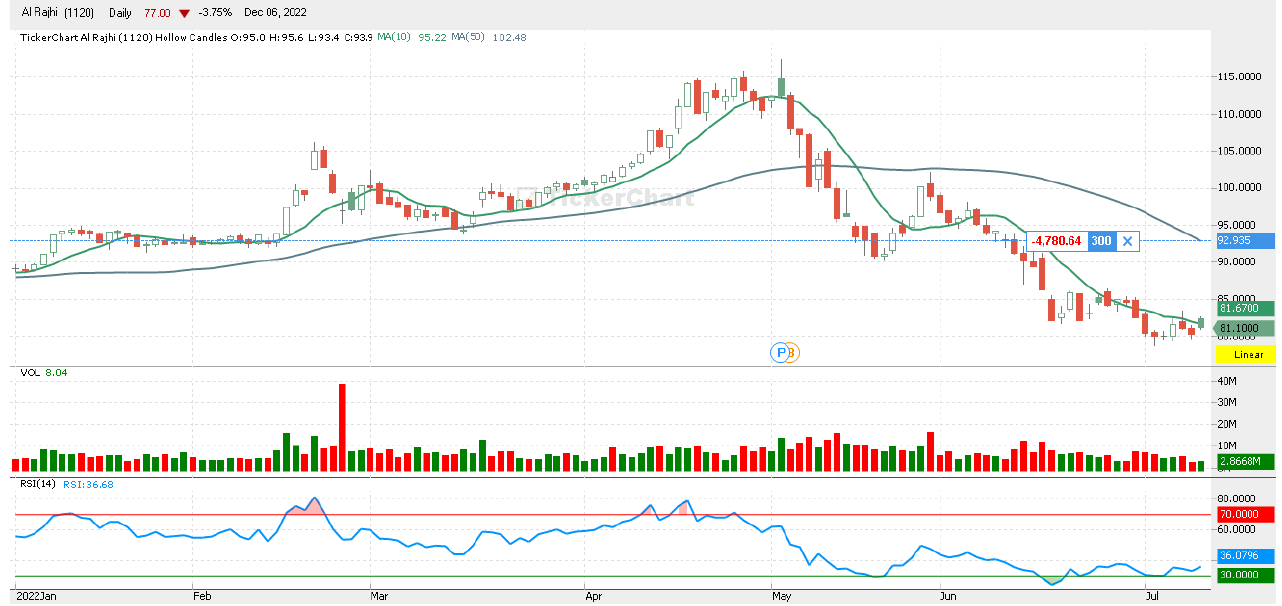
Figure 2. Stock Price Chart with technical